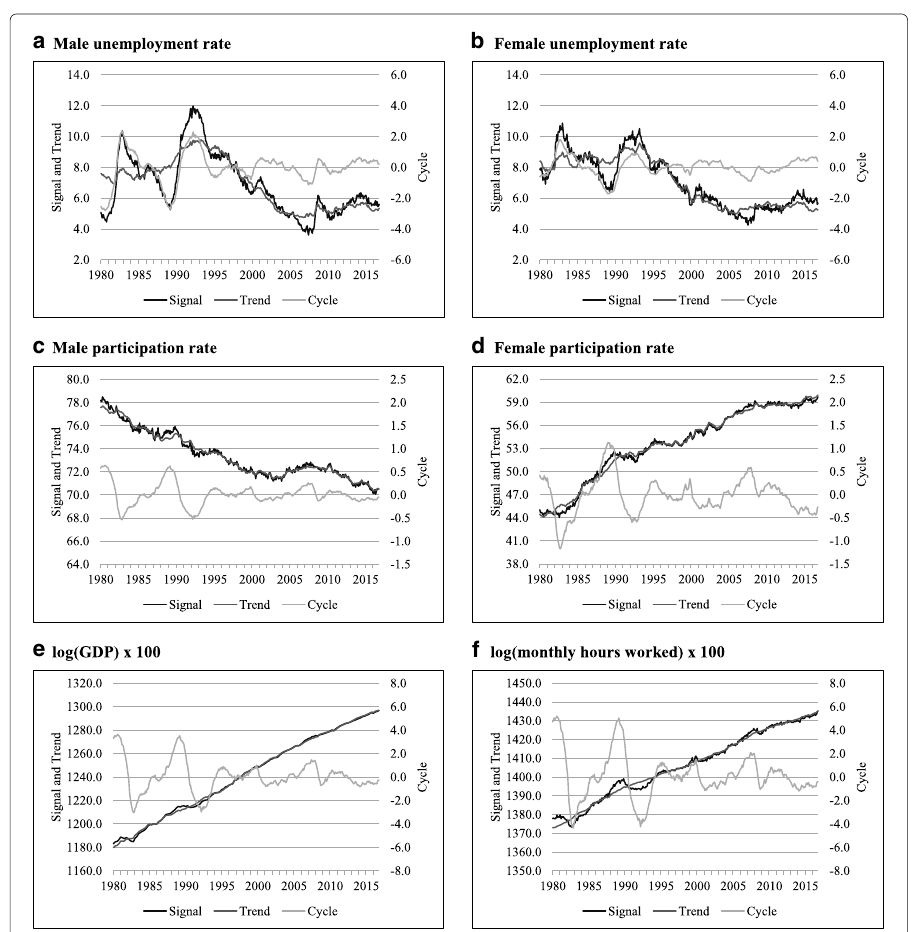
Fig. 2 Smoothed trend and cycle components. a Male unemployment rate. b Female unemployment rate. c Male participation rate. d Female participation rate. Notes: The smoothed components for g t and h t in graphs e log(GDP) × 100 and f log(monthly hours worked) × 100 were those jointly estimated with the male unemployment and participation